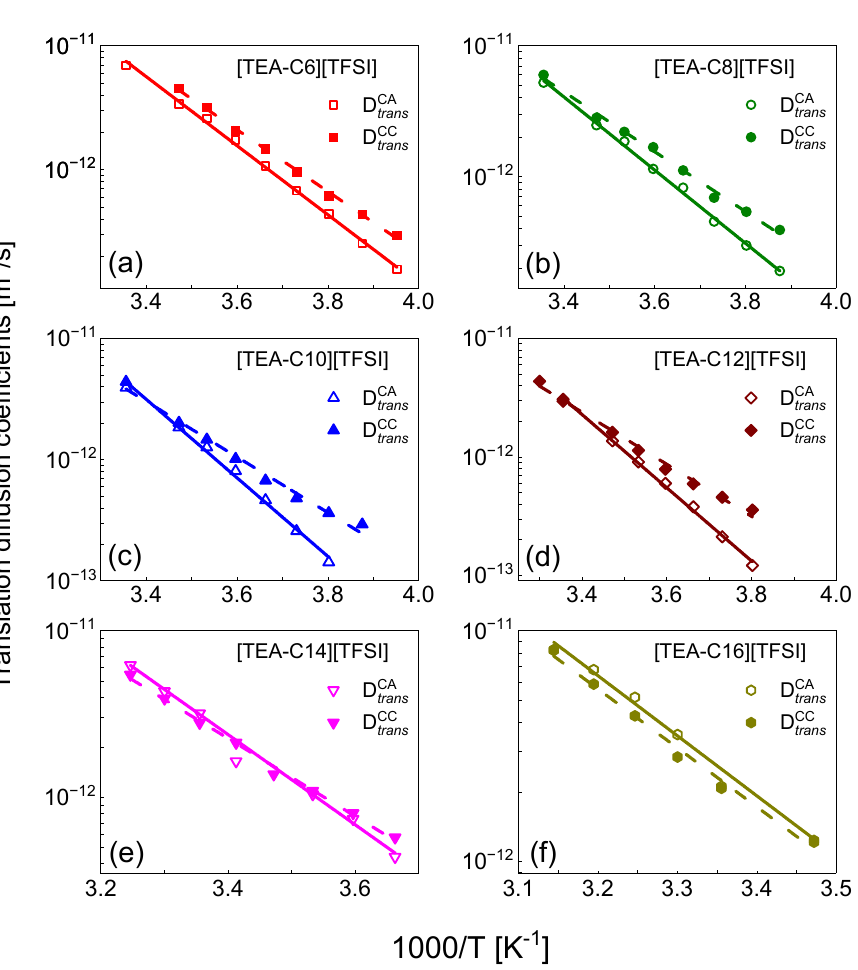
Figure 4. Relative cation–anion translation diffusion coefficients, 𝐷 (cid:3047)(cid:3045)(cid:3028)(cid:3041)(cid:3046)(cid:3004)(cid:3002) , and cation–cat- ion translation diffusion coefficients, 𝐷 (cid:3047)(cid:3045)(cid:3028)(cid:3041)(cid:3046)(cid:3004)(cid:3004) , for ( a ) [TEA–C6] [TFSI], ( b ) [TEA–C8] [TFSI],